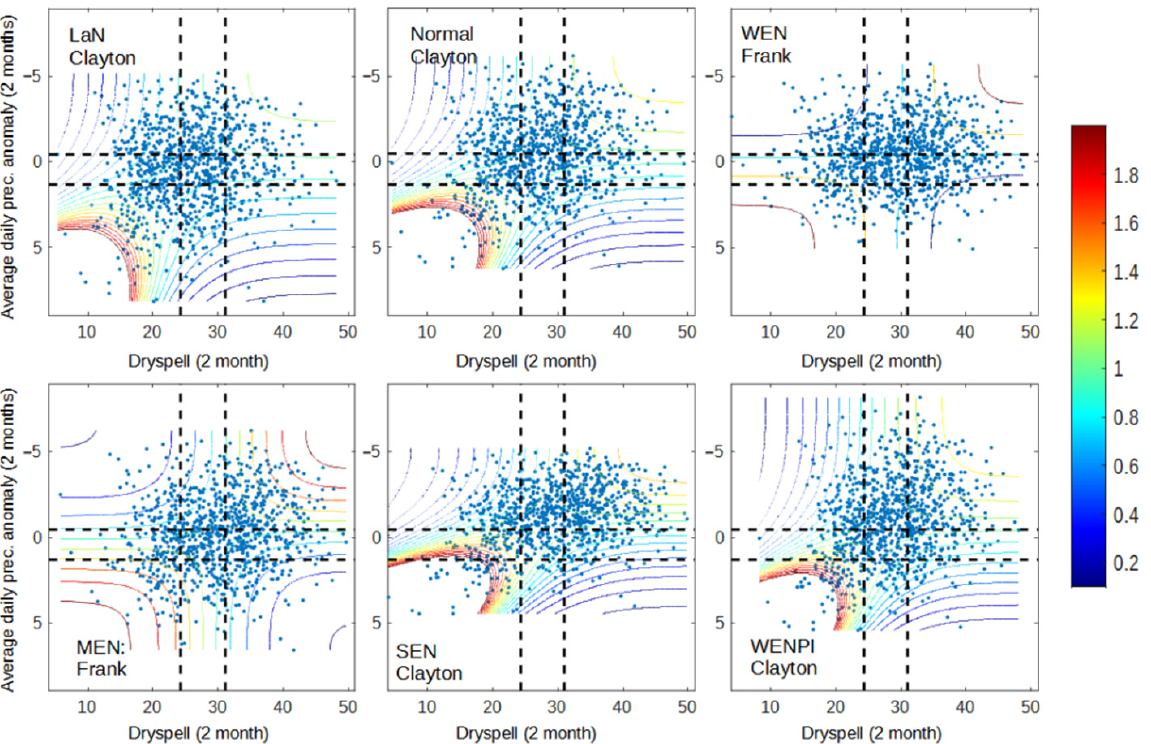
Figure 7. Dependency graph of dry spell and precipitation anomaly for 2001–2020 data. The dashed lines represent the separation of wet ( bottom / left ), normal ( middle ), and dry ( up / right ) conditions for dry spell (vertical line) and precipitation anomaly (horizontal line).